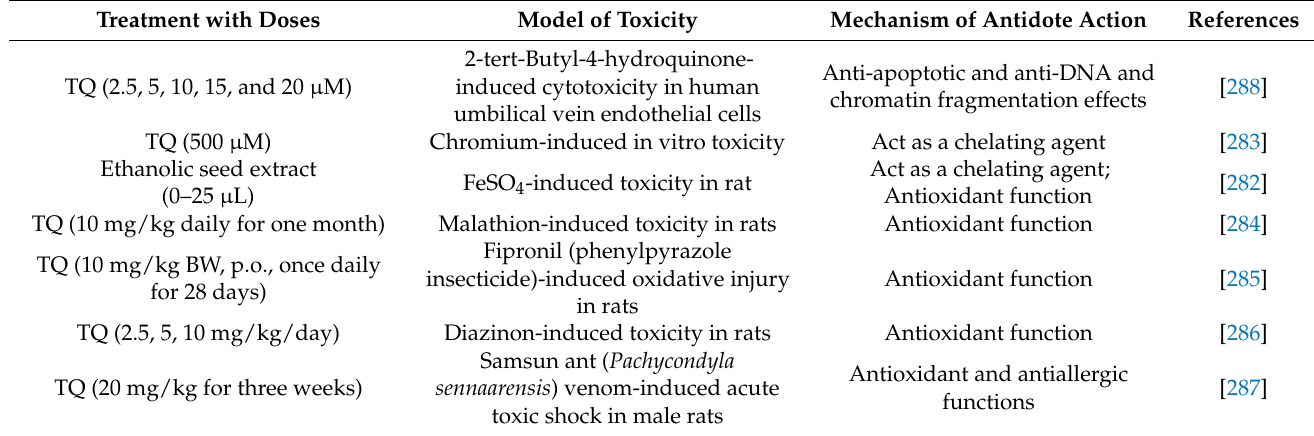
Table 11. Antidotal effects of black cumin and its